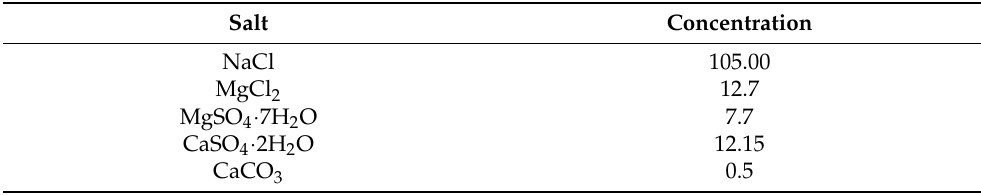
Table 3. Chemical composition of the artificial seawater.